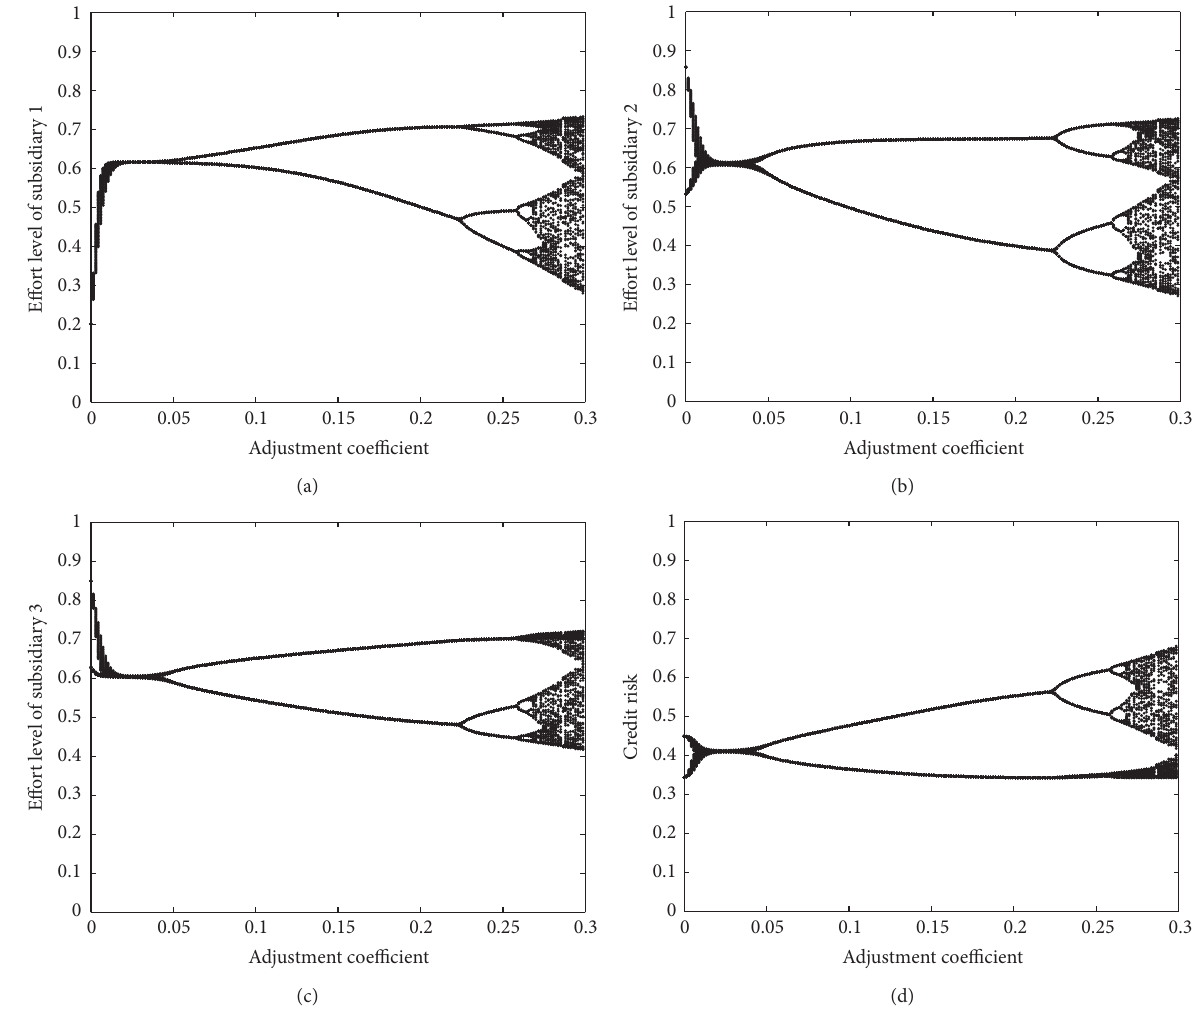
Figure 3: Bifurcations of the decision-making process and the credit